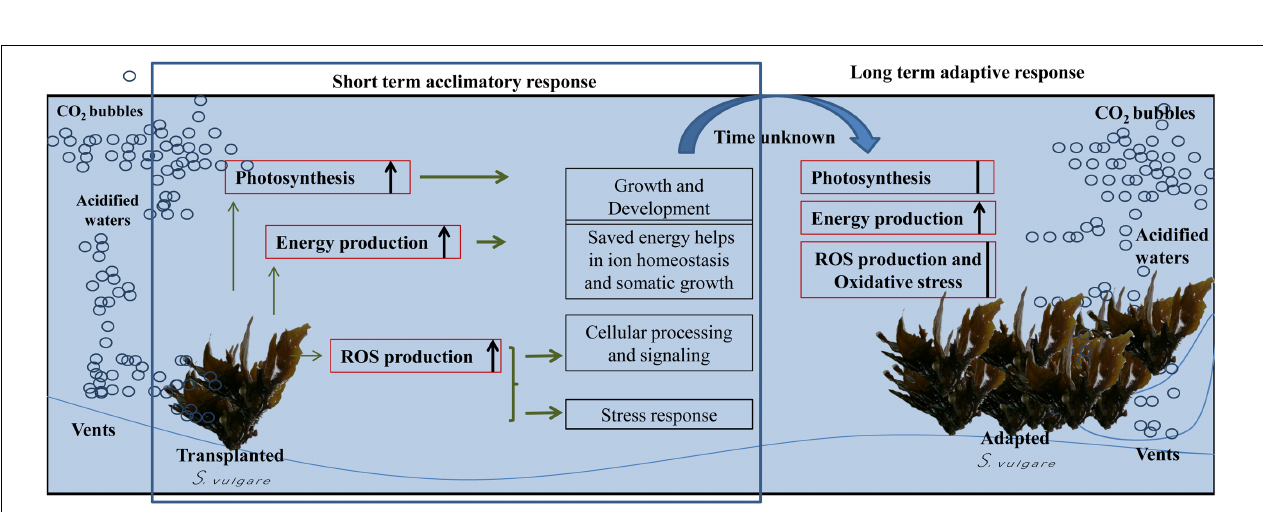
FIGURE 6 | Summary of possible series of events happened to S. vulgare at the acidified site. Red boxes: examined processes; black boxes: hypothesized processes.